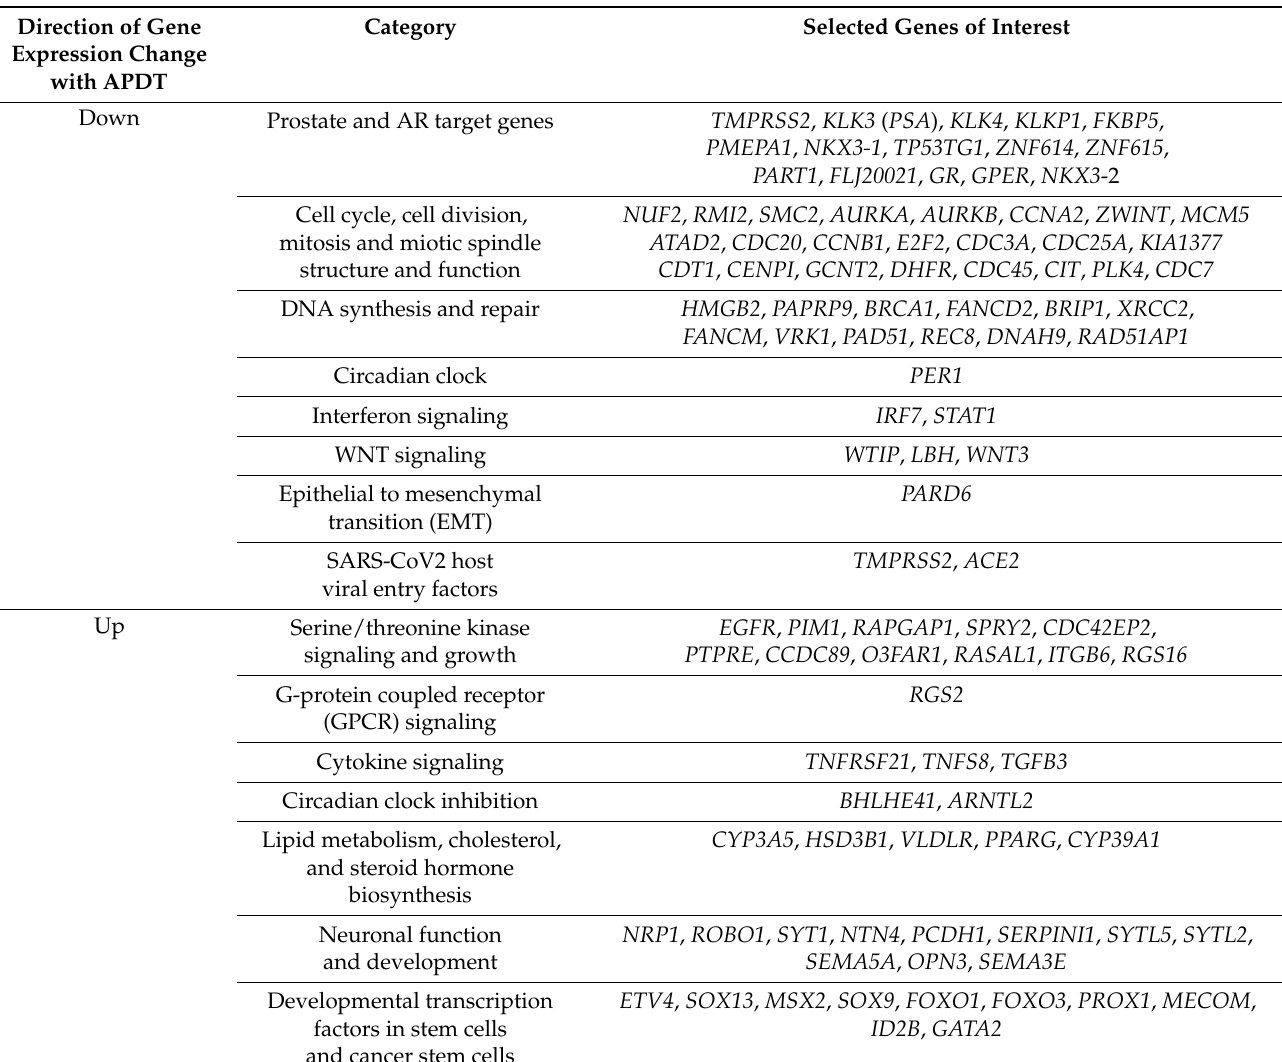
Table 1. Selected genes of interest in APDT-signature from PDX PCSD1